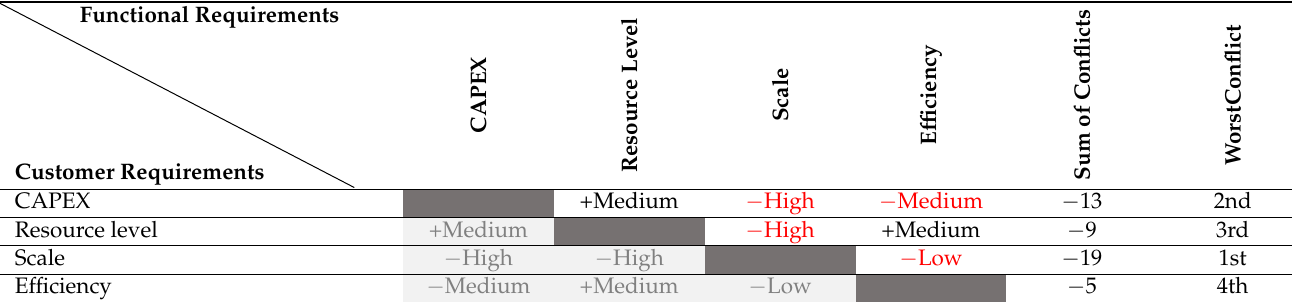
Table 6. Use case showing the interdependencies between the functional requirements for the wave energy example, showing the strength of the relationships (high, medium, low, none) and type of correlation (positive/negative). Grey shading used to highlight the symmetric nature of interdependence; Text in red to highlight conflicting requirements.